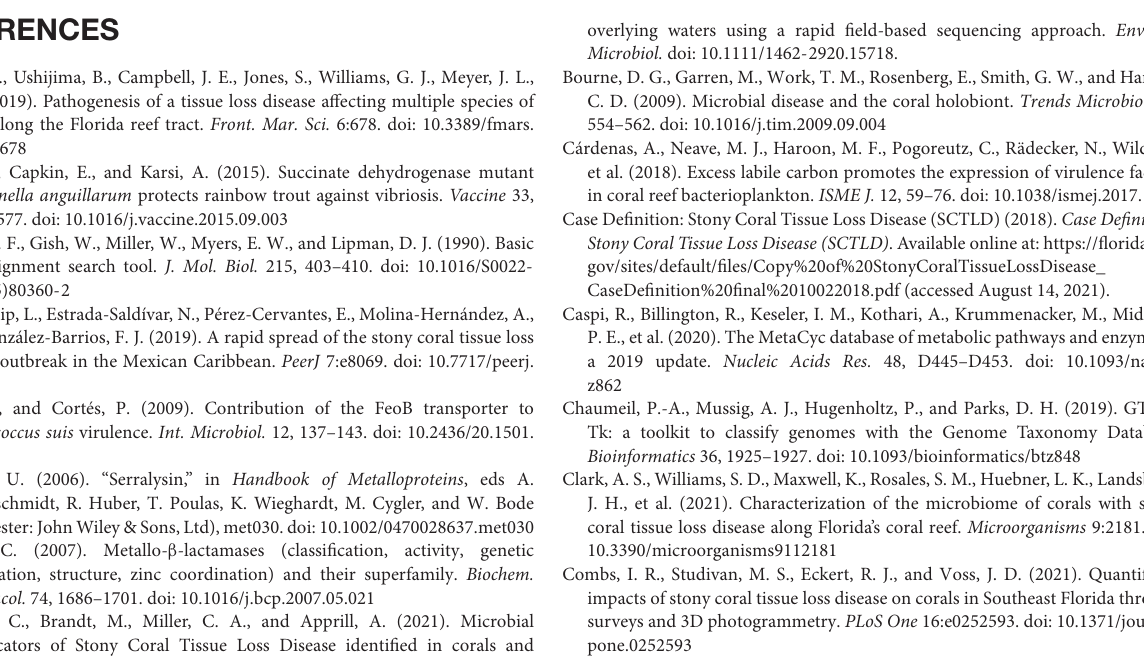
Supplementary Figure 4 | The coverage of KEGG pathways across 16 metagenome-assembled genomes (MAGs) based on KEGG Decoder. The heatmap represents the completeness of each module with “1” (red) indicating a complete module and “0” (deep blue) indicating that the module is not present. The MAGs ( x -axis) are labeled by bin number and the lowest taxonomic assignment designated. The x -axis is hierarchically clustered by Euclidean distance among the pathways present in each MAG (bottom) and colored (as in Figure 3 ) by the respective bacterial order and by genome completeness of the MAGs (top) . Supplementary Figure 5 | Gene counts of miscellaneous genes across 16 metagenome-assembled genomes (MAGs). The heatmap represents the number of gene counts (square root transformed) found in each MAG from DRAM’s miscellaneous assignments. The MAGs ( x -axis) are labeled by bin number and the lowest taxonomic assignment designated. The x -axis is hierarchically clustered by Euclidean distance among the genes present in each MAG genetic similarity (bottom) and colored (as in Figure 3 ) by the respective bacterial order and by genome completeness of the MAGs (top). Supplementary File 1 | Details on the metagenome libraries and the metagenome assembly statistics from all coral samples from apparently healthy colonies (AH), and unaffected (DU) and lesion (DL) tissues on diseased colonies, for the coral species Stephanocoenia intersepta (SINT), Diploria labyrinthiformis (DLAB), Dichocoenia stokesii (DSTO), and Meandrina meandrites (MMEA). Supplementary File 2 | A list of significantly differentially abundant small subunit (SSU) rRNA (padj ≤ 0.05) from bacteria and eukaryotes from all coral samples from apparently healthy colonies (AH), and unaffected (DU) and lesion (DL) tissues on diseased colonies, for the coral species Stephanocoenia intersepta (SINT), Diploria labyrinthiformis (DLAB), Dichocoenia stokesii (DSTO), and Meandrina meandrites (MMEA). Supplementary File 3 | Summary of statistics for each metagenome-assembled genome (MAG) phylogenetic classification. Statistical outputs were generated by the programs Genome Taxonomy Database Toolkit (GTDB-Tk) and